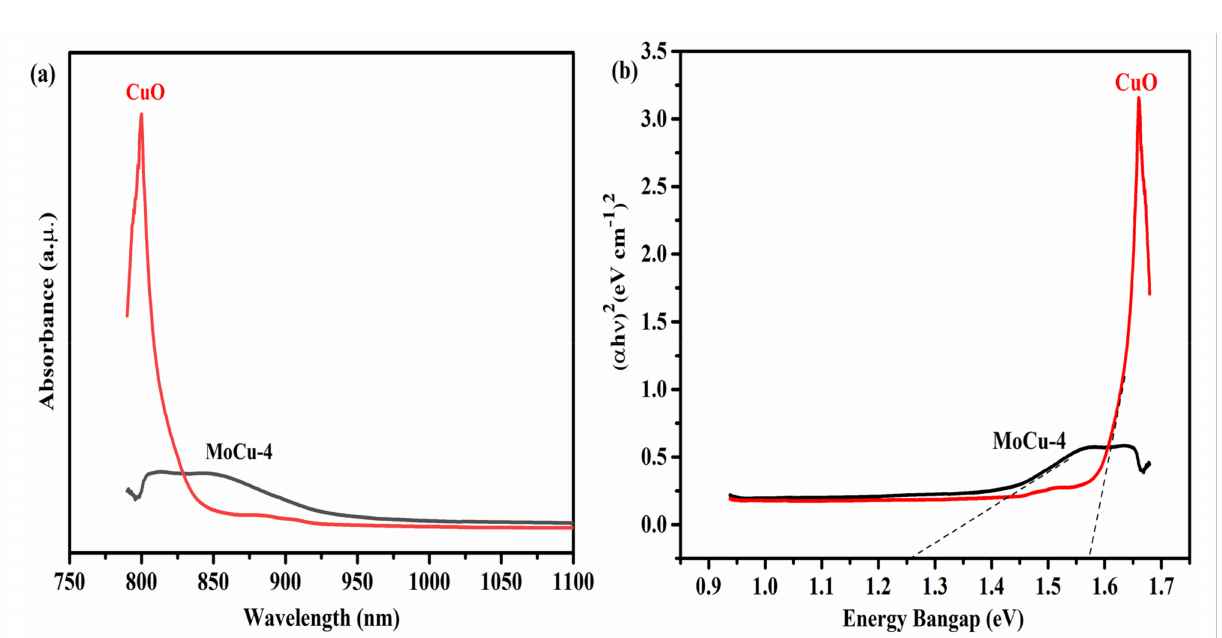
Figure 5. ( a ) UV-vis absorbance of pure CuO and MoCu-4 samples and ( b ) Tauc plot of pure CuO and MoCu-4